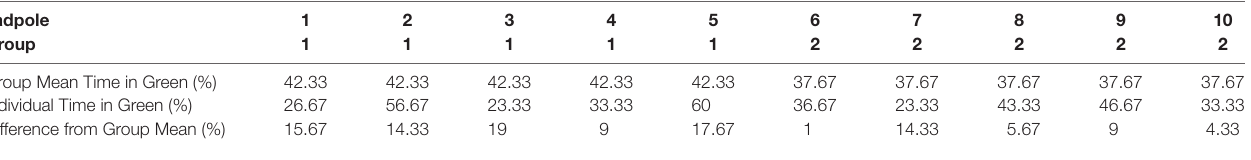
TABLE 1 | Preference for green displayed by individual tadpoles compared to the group preference. Tadpole